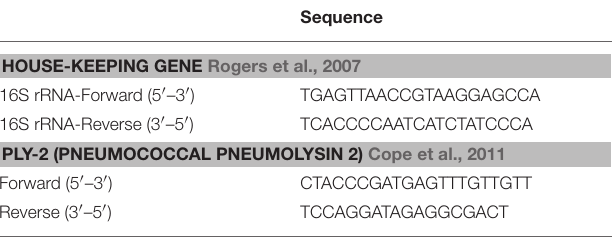
TABLE 1 | List of primer sequences and target